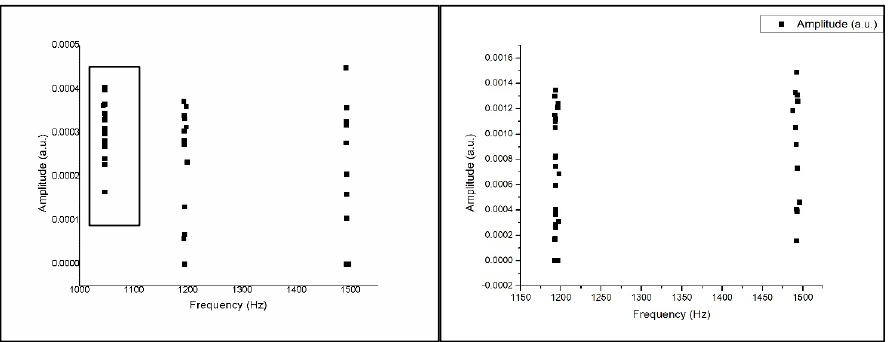
Figure 21. For example, if an error occurs and is normal. As seen in the left picture, when there is a sound difference during the sound detec- tion monitoring process, the result of the frequency that appears on the monitor does not match the sound rhythm when it is normal. So, we can find out by monitoring if there is a difference in the spectrum during the milling process on a CNC.